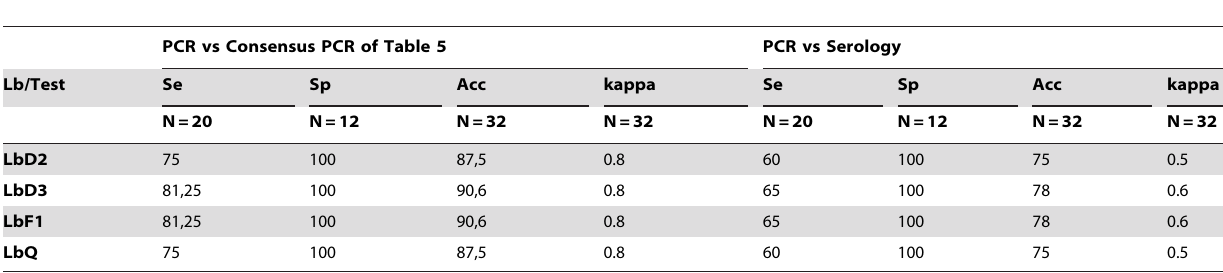
Table 6. Intra-Laboratory Evaluation of the four Best Performing Methods in samples from Table 5.